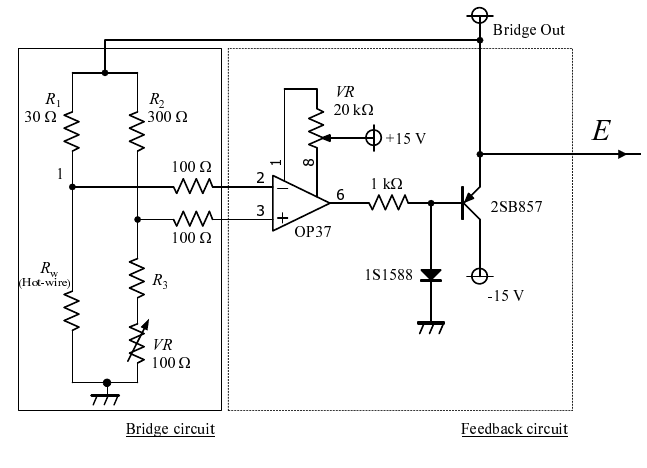
Fig. 4 Block diagram of the constant temperature